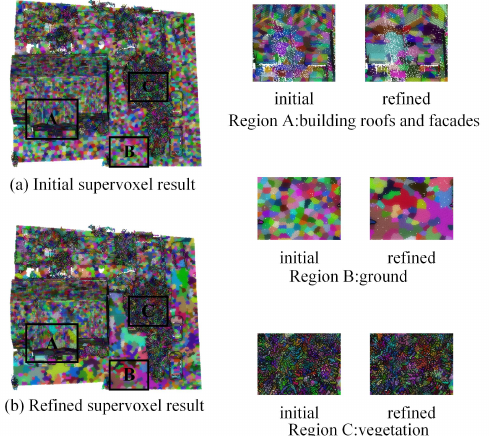
Figure 4 . Comparison of the results before and after the proposed algorithm.